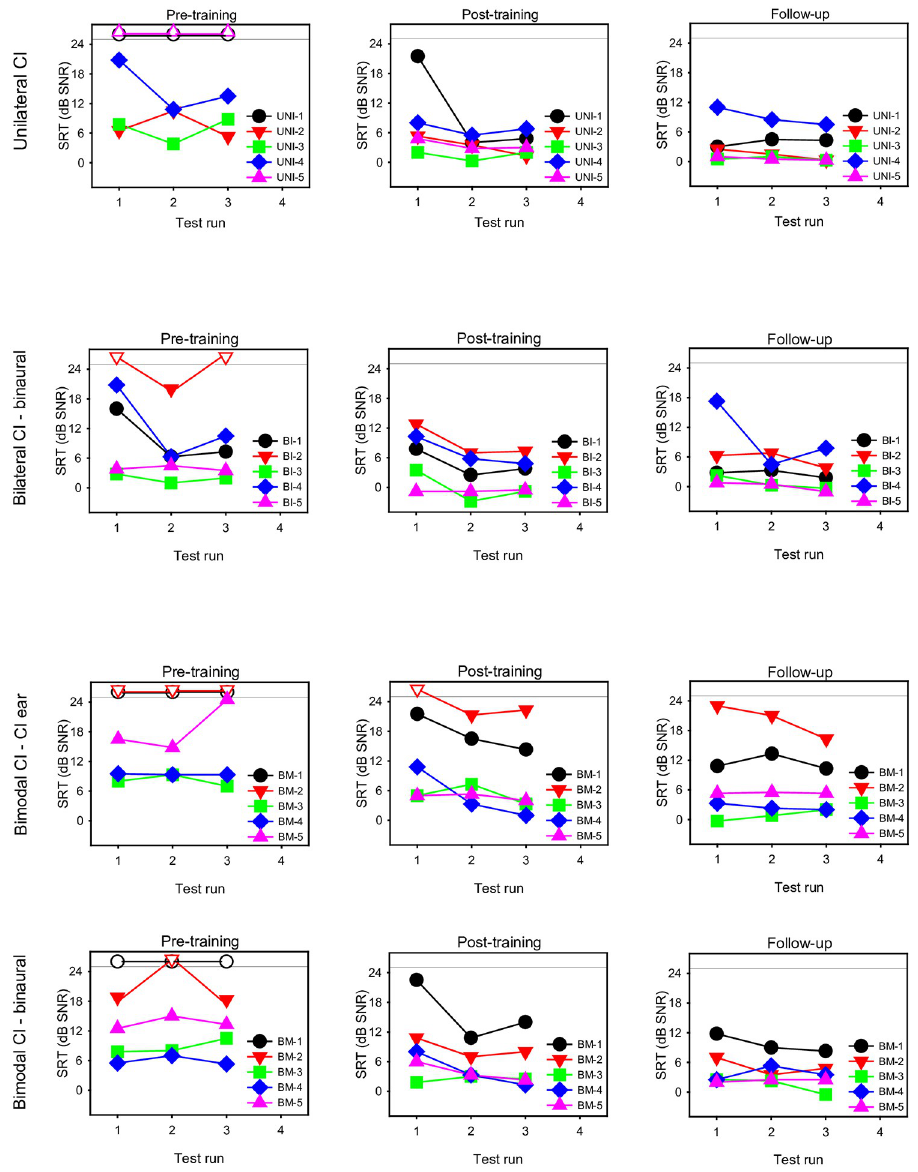
Fig 5. SRTs for individual participants as a function of test run. Pre-training (left column), post-training (middle column), and follow-up data (right column) are shown for the unilateral group (top row), bilateral group with binaural listening (middle row), and the bimodal group with CI-only and binaural listening (bottom two rows). The horizontal line shows the maximum SNR (25 dB) before the test run was aborted. The open symbols show test runs that exceeded the maximum SRT (25 dB